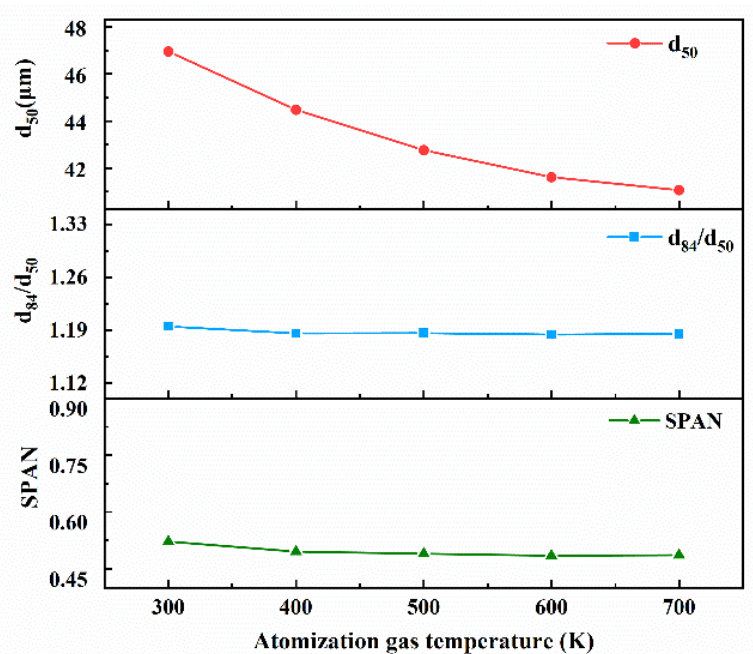
Figure 16. The e ff ect of operating temperature on d 50 , d 84 / d 50 and SPAN for the KHRT breakup Figure 16. The effect of operating temperature on d 50 , d 84 /d 50 and SPAN for the KHRT breakup model model simulation.